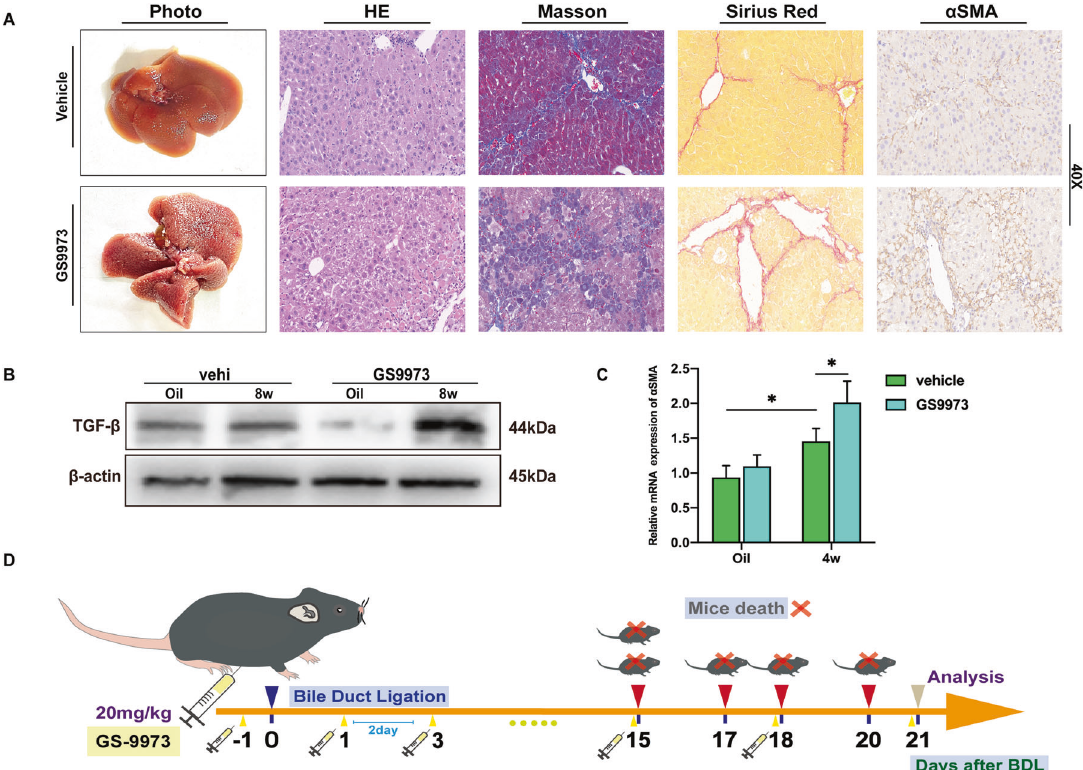
Fig. 6 High-frequency injection of GS9973 aggravated liver fi brosis. A Mice were intraperitoneally injected with GS9973 (20 mg/kg, q2d), 4 weeks after CCL4 injection, the degree of liver fi brosis was observed by photographs, HE, masson, Sirius red staining, and immunohistochemistry of α -SMA; B Mice were injected with GS9973 (20 mg/kg, q3d), the protein level of TGF- β in the liver was measured after 8 weeks of CCL4 injection; C The mRNA level of α -SMA was evaluated after 4 weeks; D The administration of GS9973 (20 mg/kg, q2d, ip) caused the death of mice with